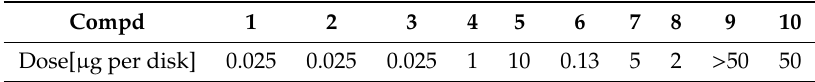
Table 8. Minimum doses of miuraenamides and derivatives for anti- Phytophthora activity from Reference [49].